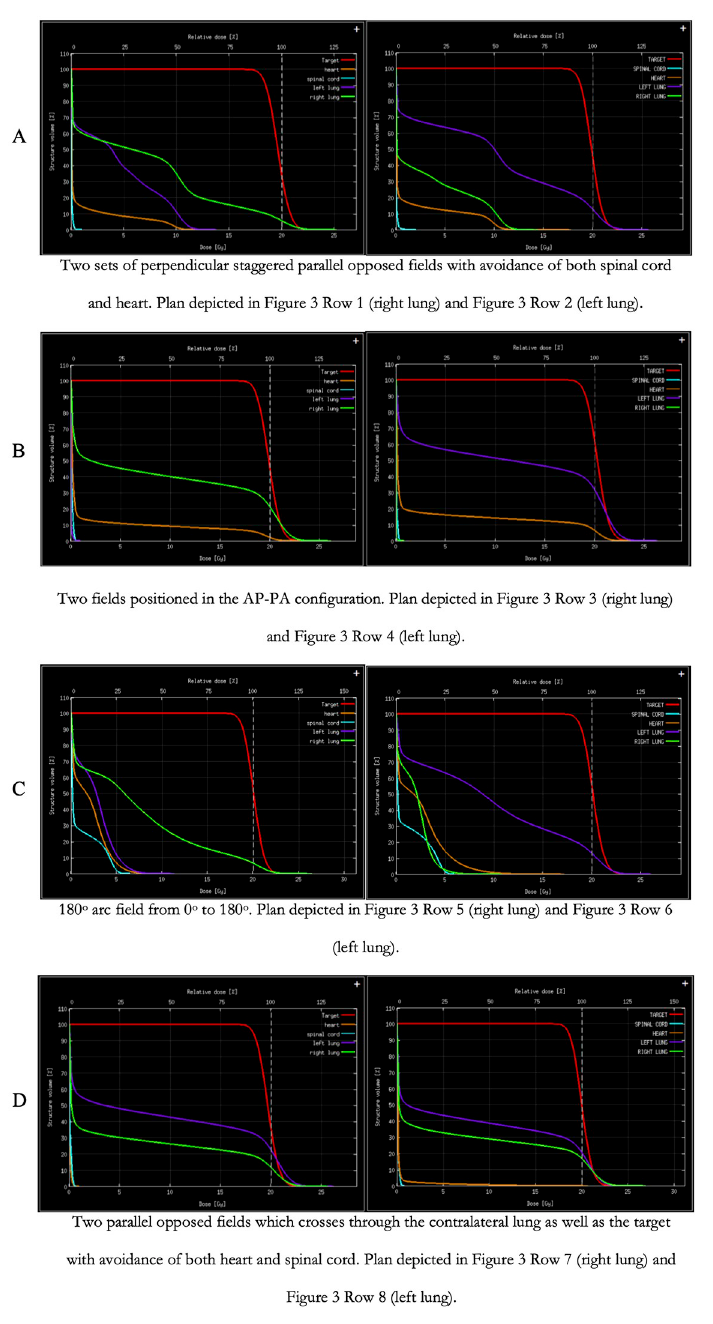
Fig 9. DVHs of different treatment plans. Consistent across all DVHs are dose characteristics of the target, delineating the gross tumor volume (red), the heart (orange), spinal cord (cyan), purple (left lung) and green (right lung). The DVHs were separated into right lung (left column) and left lung (right column) DVHs. With each row representing the different treatment plans. precise quantitative tumor tracking of dynamic tumor response. Our model was able to dem- onstrate that the H1299 cell line generates consistent singular nodules, when surgically implanted, validating previously published protocol [18], and can be injected into either the left or right lung to yield singular nodules appropriate for conformal external beam RT